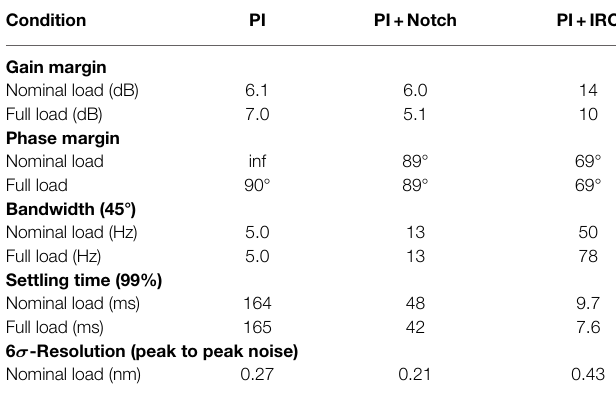
TABLE 2 | Closed-loop performance comparison of the integral, inversion, and damping controllers .